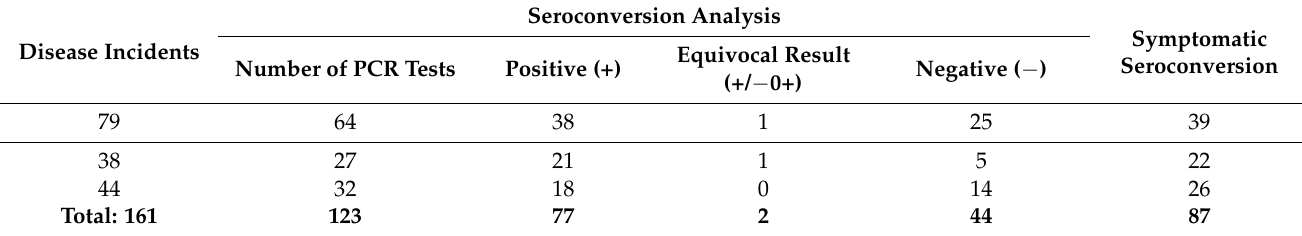
Table 7. The analysis of seroconversion in SARS-CoV-2 event participants.